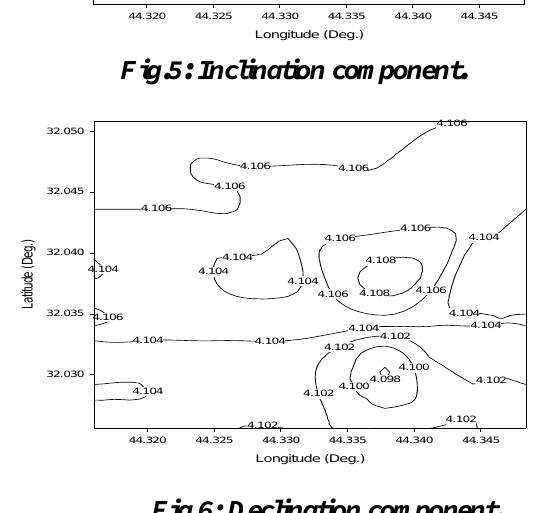
Fig.6: Declination component .